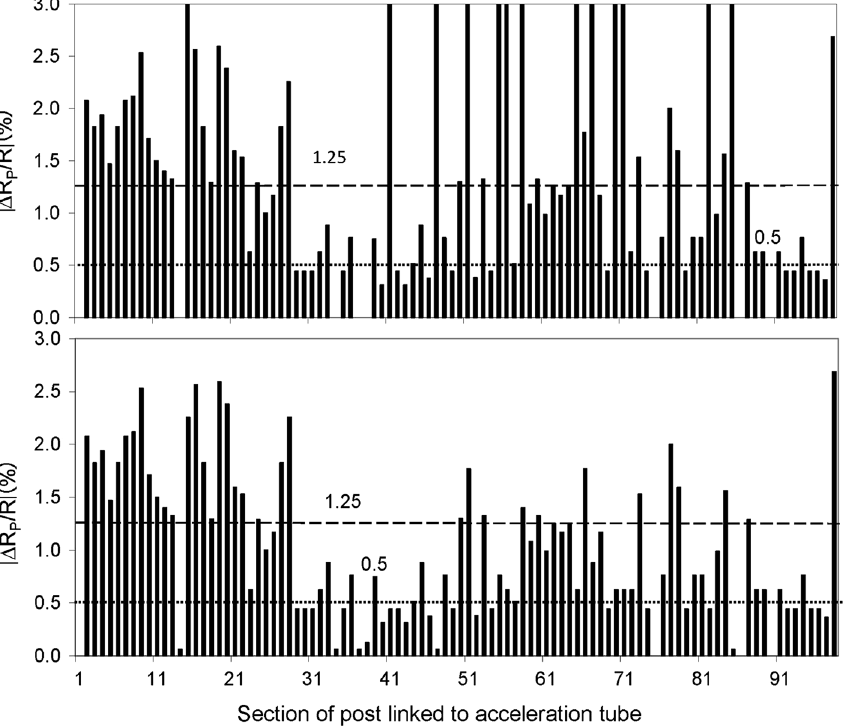
j in the post structure linked to the max